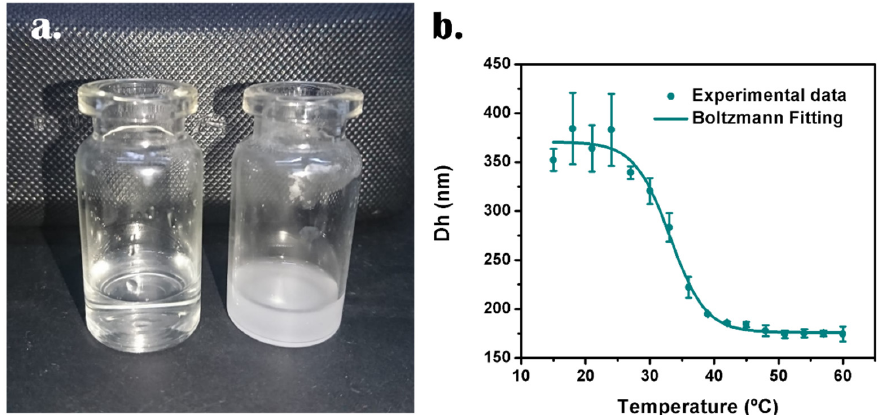
Figure 5. ( a ) Photograph representing the thermo-response of HNG-P(DEGMA-co-IA 12 ): on the left, the suspension at room temperature and on the right, the same suspension at around 60 °C. ( b ) Average Dh vs. temperature of HNG-P(DEGMA-co-IA 12 ).